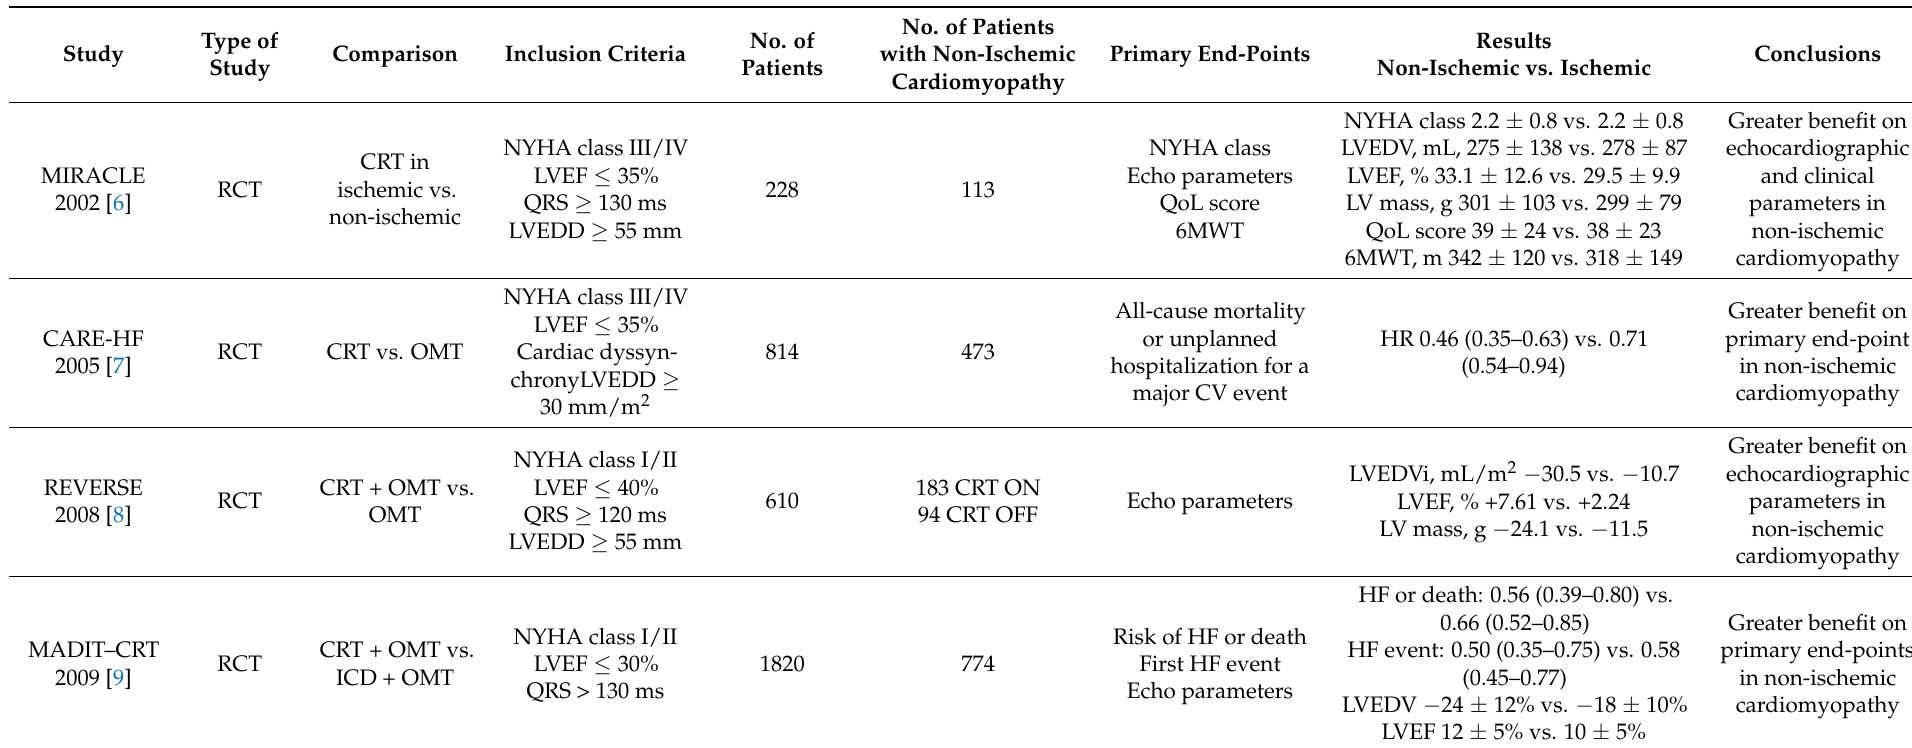
Table 1. Summary of studies investigating cardiac resynchronization therapy (CRT) in non-ischemic dilated cardiomyopathy